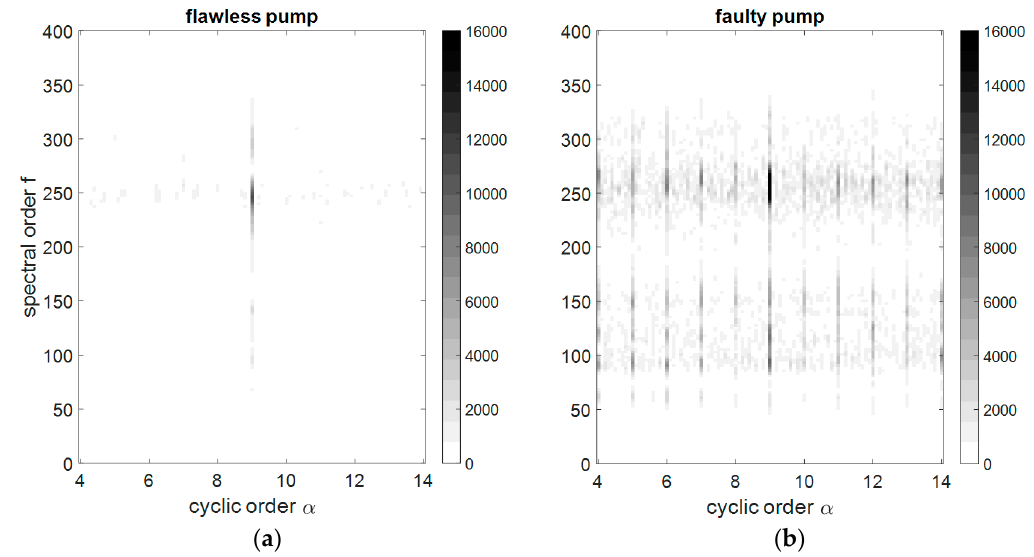
Figure 16. SCD around the cyclic order 9 for the signals acquired with sensor 2 at 2000 r/min and 250 bar ( ∆ α = 0.1, ∆ f = 2.5). ( a ) flawless pump; ( b ) faulty pump.